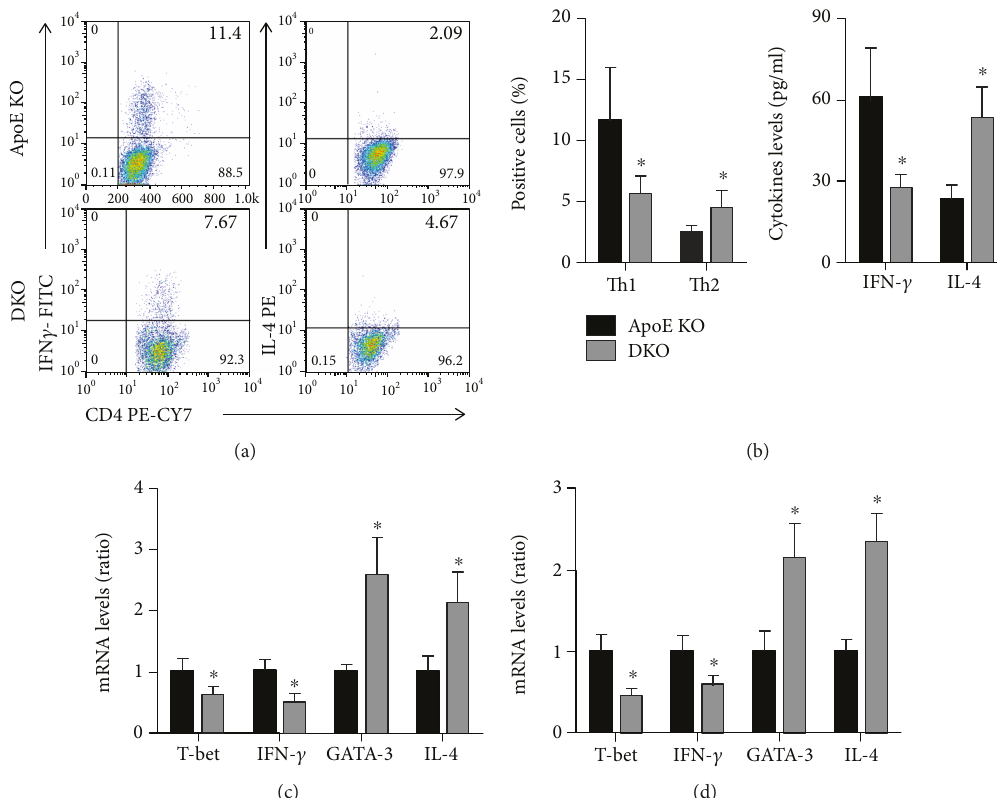
Figure 3: E ff ect of IL-12p35 de fi ciency on the activity of Th1 and Th2. (a) The frequency of Th1 and Th2 in ApoE-/- mice and ApoE-/- IL-12p35-/- mice was measured by fl ow cytometry, n = 10 for each group. (b) The serum IFN- γ and IL-4 levels were detected by ELISA; n = 16 for each group. (c, d) The mRNA levels of T-bet, IFN- γ , GATA3, and IL-4 in the spleens and aortas of these two groups were analyzed by RT-qPCR. ApoE KO=ApoE-/-, DKO=ApoE-/- IL-12p35-/-; N = 6 for each group. ∗ P < 0 05 vs. the ApoE-/-